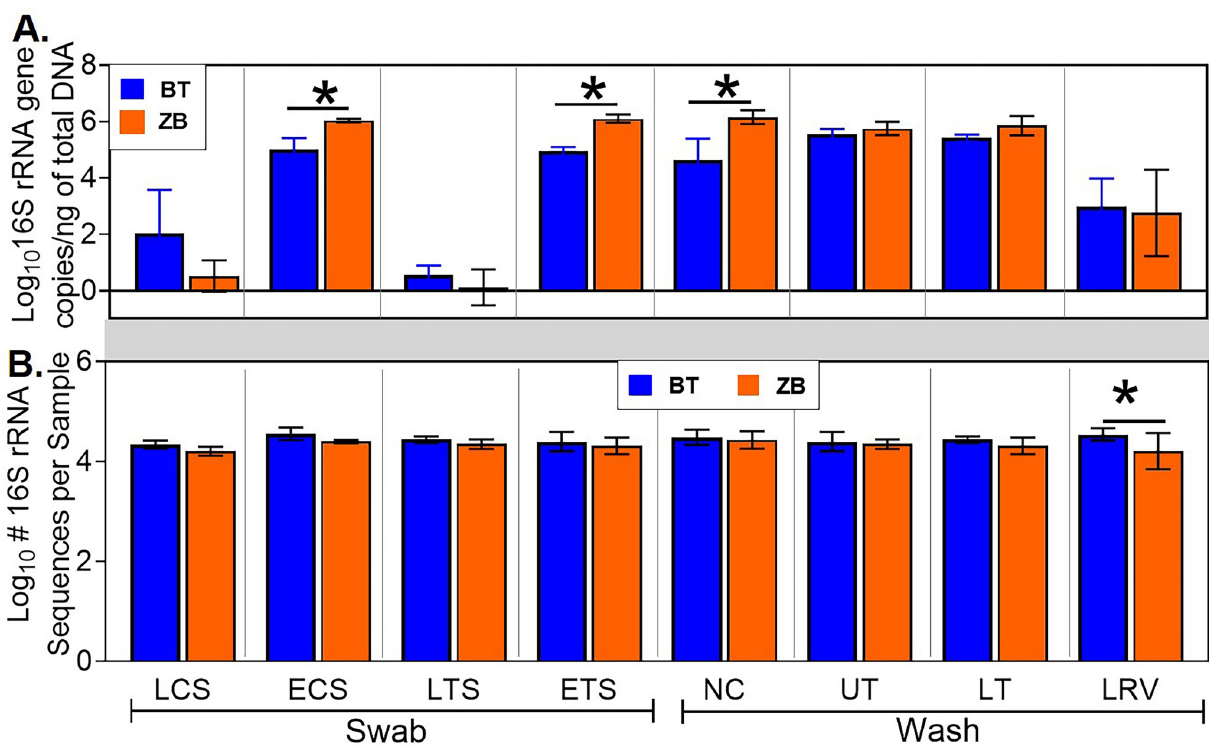
Fig 3. Between-kit comparison of pre- and post-sequencing 16S rRNA gene copies for each sample type. (A) Pre-sequencing 16S rRNA gene copies per nanogram of total DNA. Quantitative PCR was used to determine the number of 16S rRNA gene copies per μ L of sample. The DNA samples were then normalized to 1.67 × 10 5 16S rRNA gene copies/ μ L for subsequent PCR prior to sequencing. (B) Post-sequencing 16S rRNA gene sequence counts. The sequences were quality-filtered as described in Materials and methods. Statistical differences, � p < 0.05 (pairwise Kruskal-Wallis tests, with a Benjamini-Hochberg correction for false discovery). LCS, live choanal swab; ECS, euthanized choanal swab; LTS, live tracheal swab; ETS, euthanized tracheal swab; NC, nasal cavity wash; UT, upper trachea wash; LT, lower trachea wash; LRV, lower respiratory lavage.